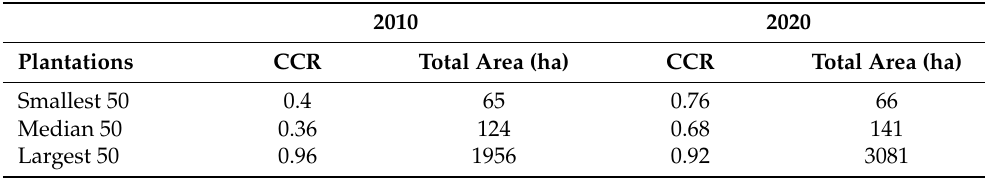
Table 10. CCR and total area of each sampled